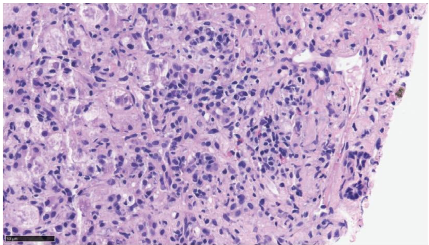
Figure 2: At 400x, plasma cells and eosinophils are easily iden- tifable as is surrounding interface activity.